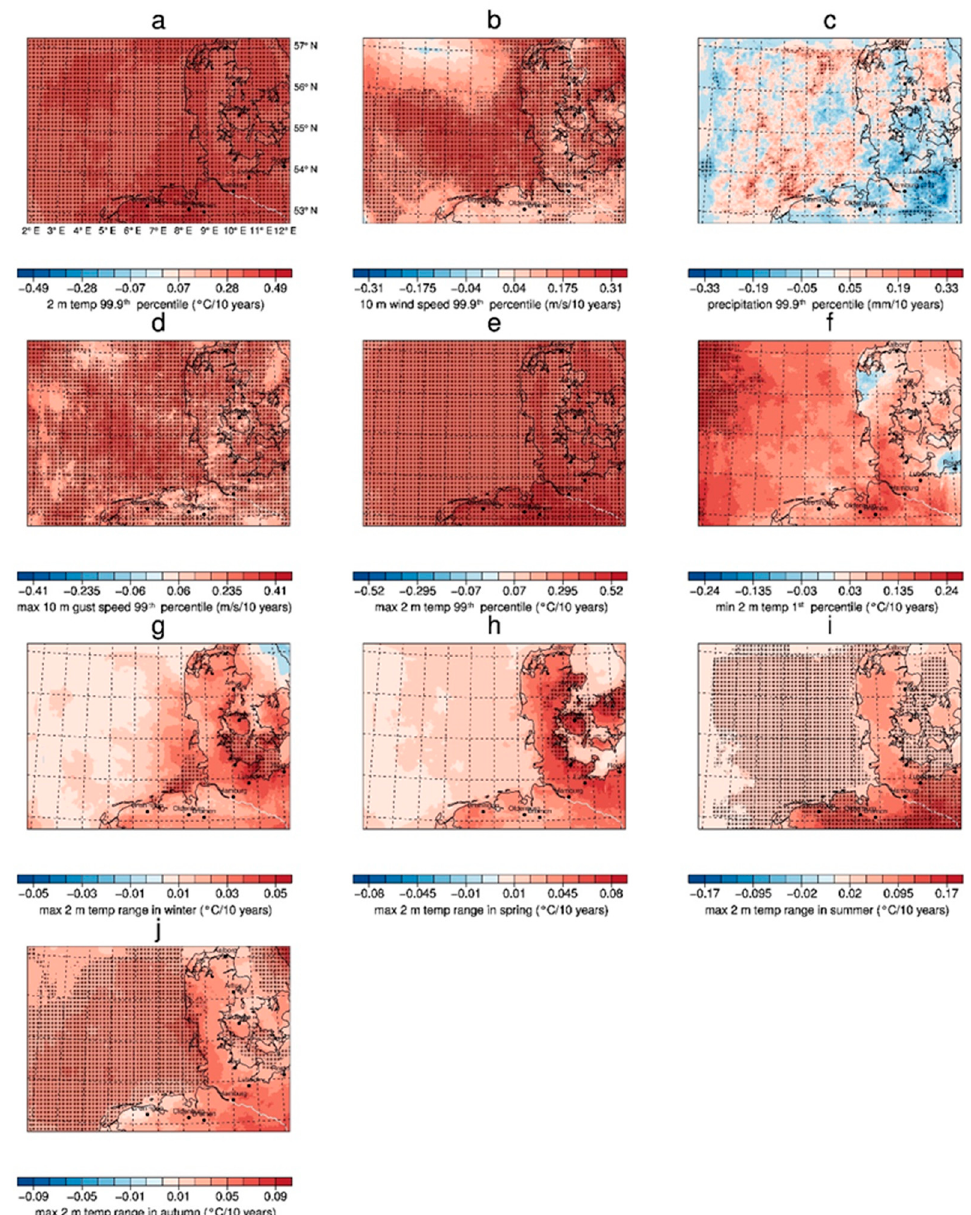
Figure 8. GB0028 decadal trends over 67 years of ( a ) annual 99.9th percentile of 2 m temperature, ( b ) annual 99.9th percentile of 10 m wind speed, ( c ) annual 99.9th percentile of precipitation, ( d ) annual 99th percentile of maximum 10 m gust speed, ( e ) annual 99th percentile maximum 2 m temperature, ( f ) annual 1st percentile of minimum 2 m temperature, ( g ) maximum 2 m temperature range in winter, ( h ) maximum 2 m temperature range in spring, ( i ) maximum 2 m temperature range in summer, ( j ) maximum 2 m temperature range in autumn. Shaded areas indicate a statistical significance at the nominal 5% level.